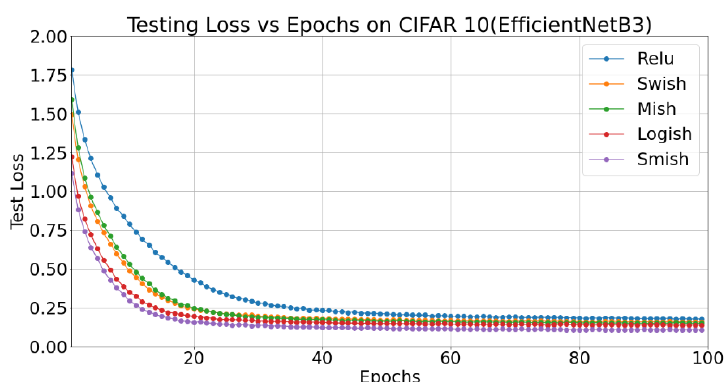
Figure 9. Accuracy vs. epoch in EfficientNetB3 achieved via the five activation functions on CIFAR10.